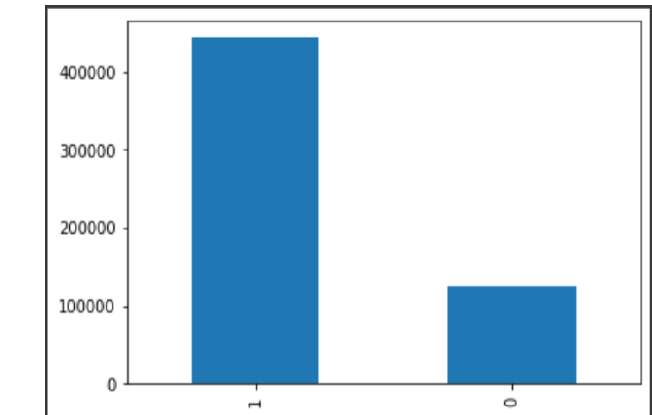
Fig. 3 System Design